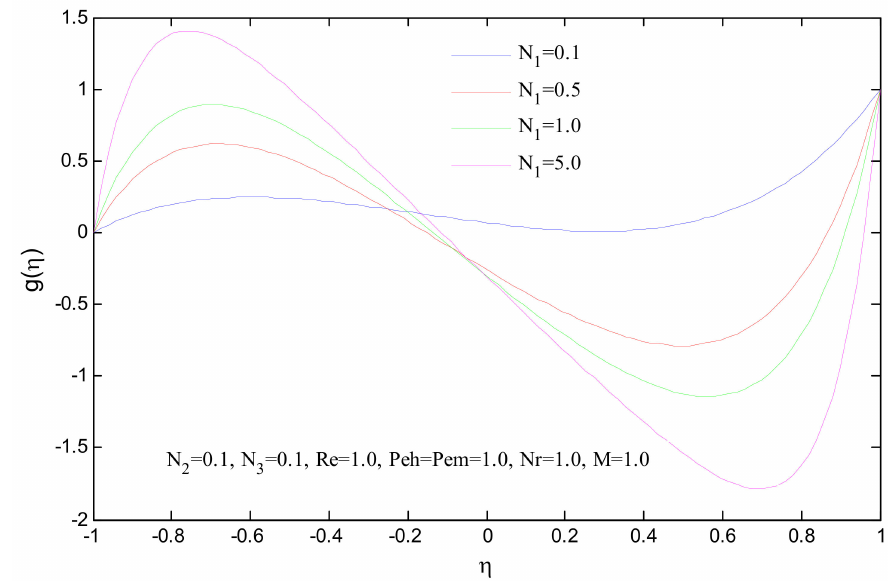
Figure 7. Effect of N 1 on microrotation